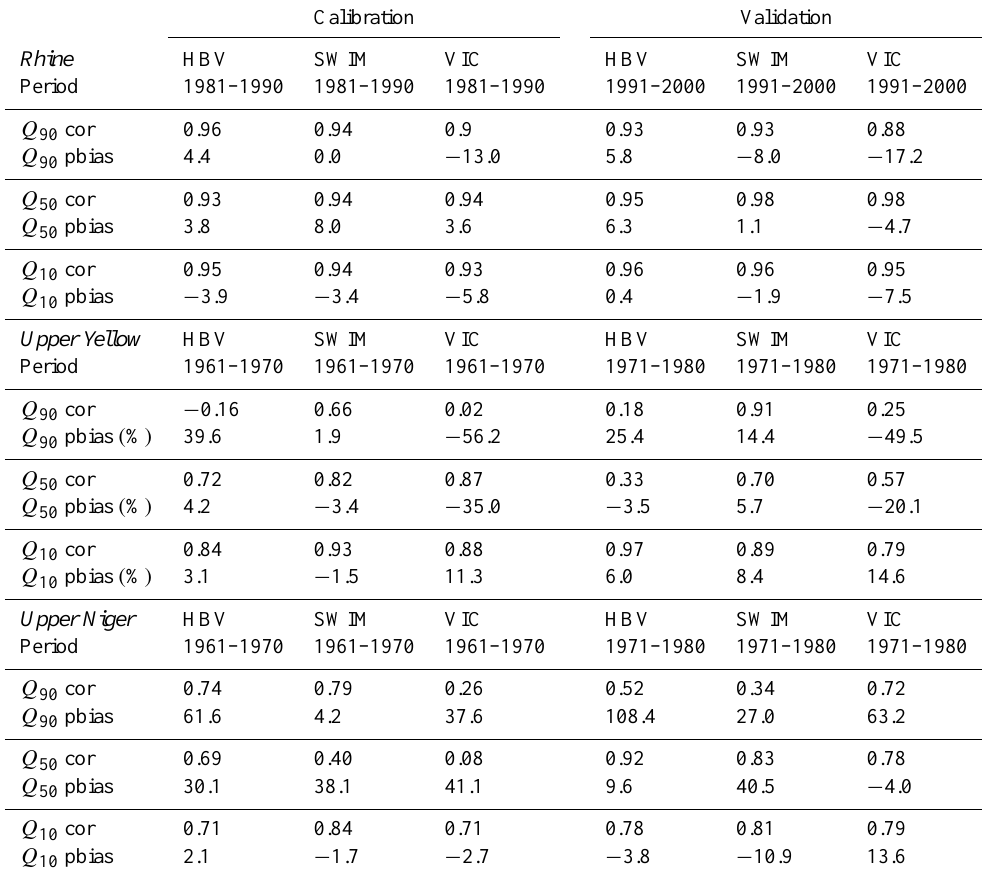
Table 4. Coefficient of correlation (cor) and percent bias (pbias) for the three runoff quantiles ( Q 90 , Q 50 , Q 10 ) in the calibration and the validation